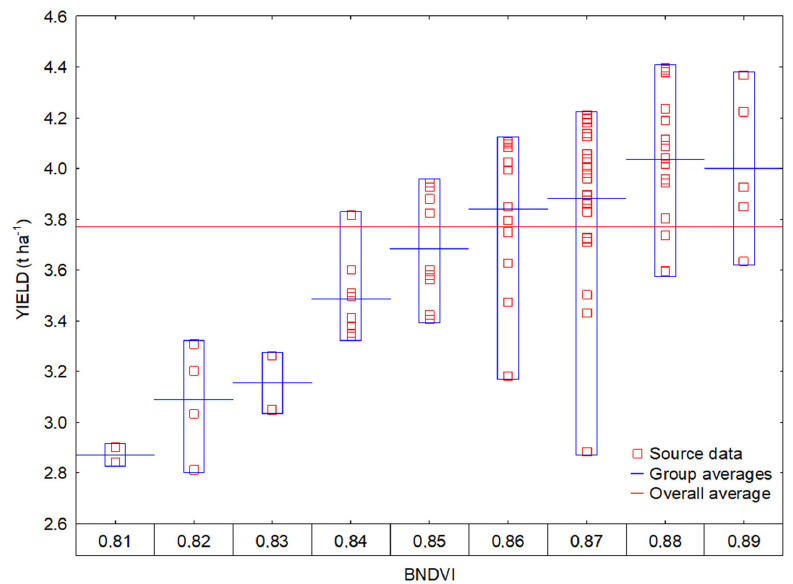
Figure 9. Graph of the variance of YIELD variable in relation to the measured BNDVI values (N = 80). Source data (red squares) show the yields of each plot ( Y − axis) divided into 9 groups according to BNDVI measured on each plot, ranging from 0.81 to 0.89 (9 values; X − axis). The parcels in each of the 9 groups have the same BNDVI value.